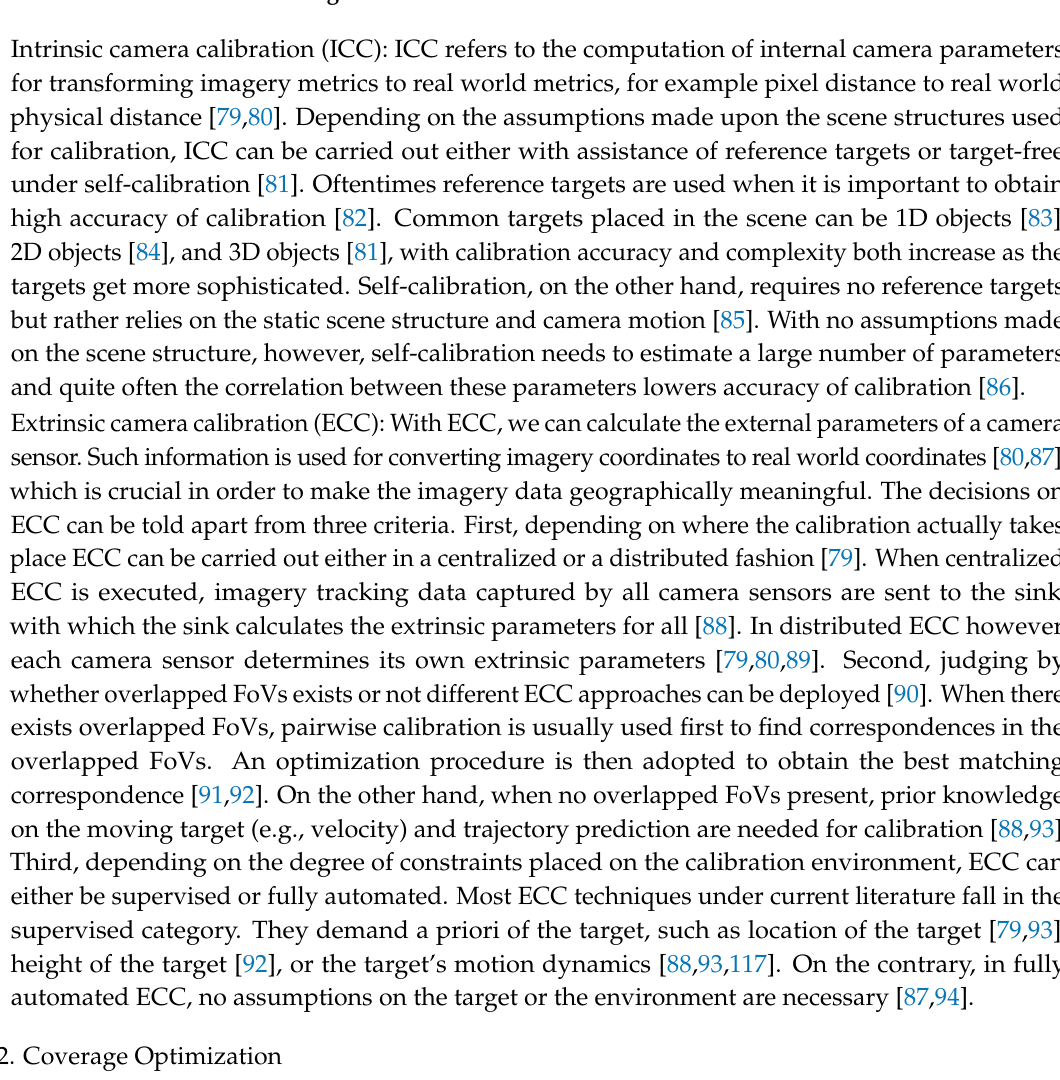
Figure 5. Camera Calibration in